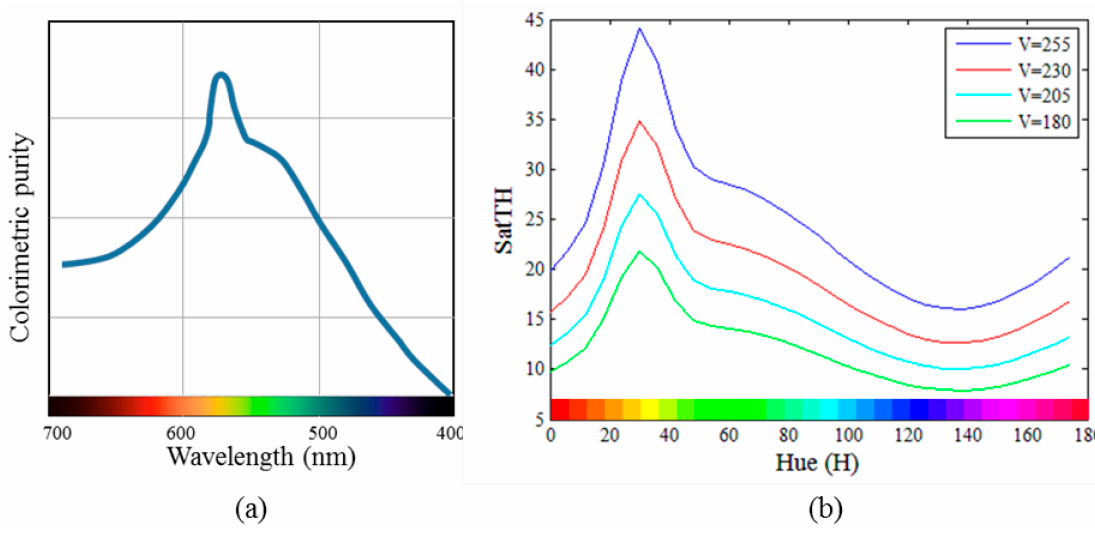
Figure 2. ( a ) The least perceptible colorimetric purity [16]; ( b ) Saturation threshold values, S , calculated using the proposed Function TH